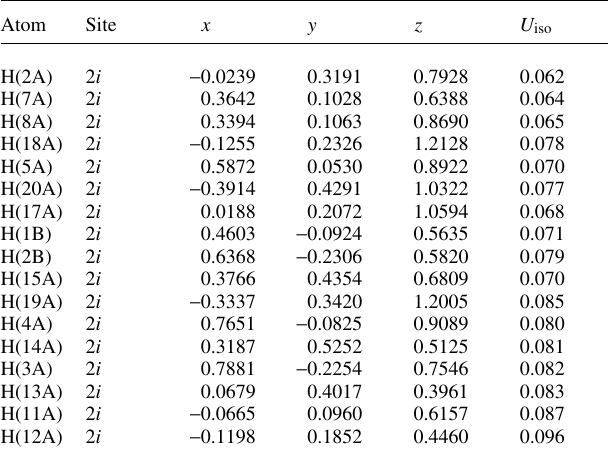
Table 2. Atomic coordinates and displacement parameters (in Å 2 )